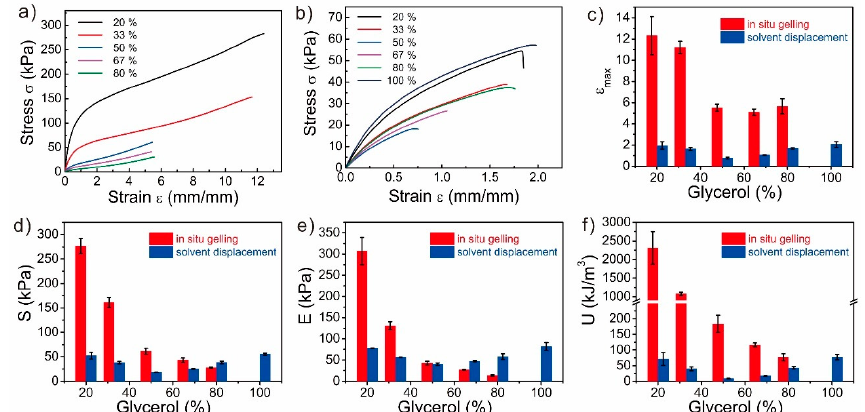
Figure 5. Mechanical properties of the PAAm gels with various glycerol contents after heating at 60 °C oven for 24 h. ( a , b ) Stress-strain curves of the PAAm gels after heating from ( a ) in-situ gelling and ( b ) solvent displacement. ( c ) Tensile strain, ( d ) tensile stress, ( e ) elastic modulus, and ( f ) toughness of the PAAm gels after heating as the functions of the glycerol content.